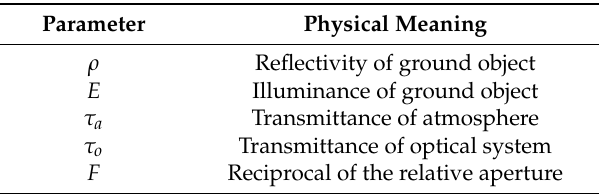
Table 2. Physical meaning of parameters in formula 1.